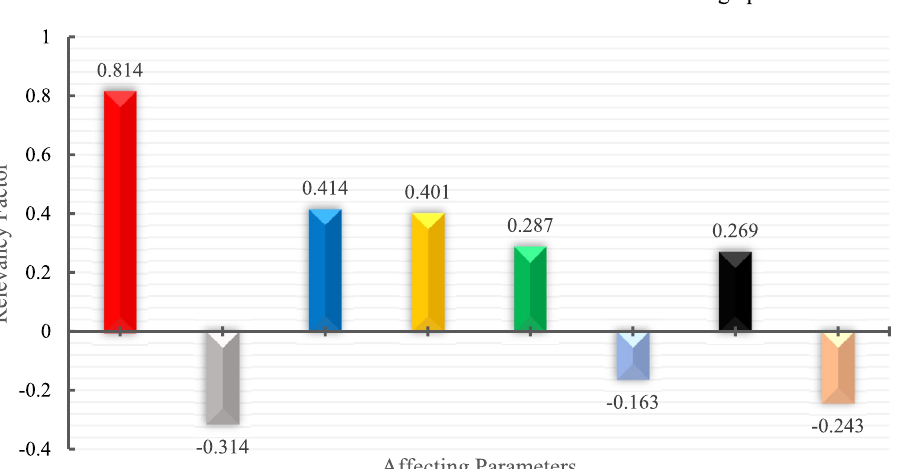
Figure 7. The effect of parameters on the asphaltenes adsorption by magnetite, hematite, calcite, and dolomite